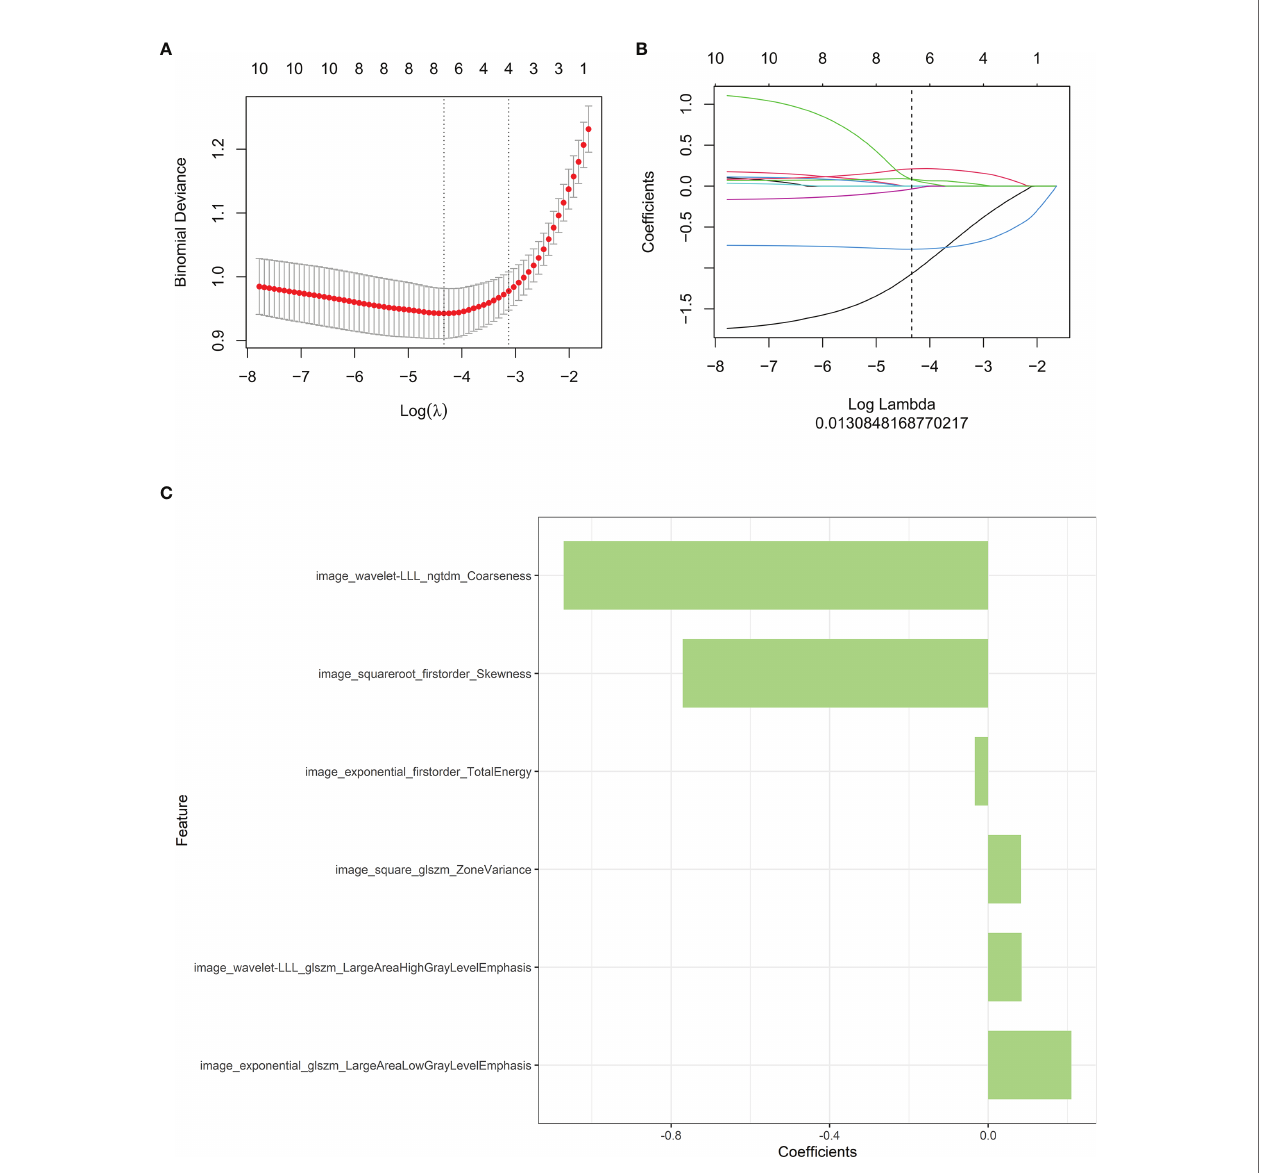
FIGURE 2 | Radiomics features associated with VPI were selected using LASSO regression models. (A) Cross-validation curve. An optimal log lambda (0.013) was selected, and 6 non-zero coef fi cients were chosen. (B) LASSO coef fi cient pro fi les of the 1316 radiomics features against the deviance explained. (C) Histogram shows the contribution of the selected parameters with their regression coef fi cients in the signature